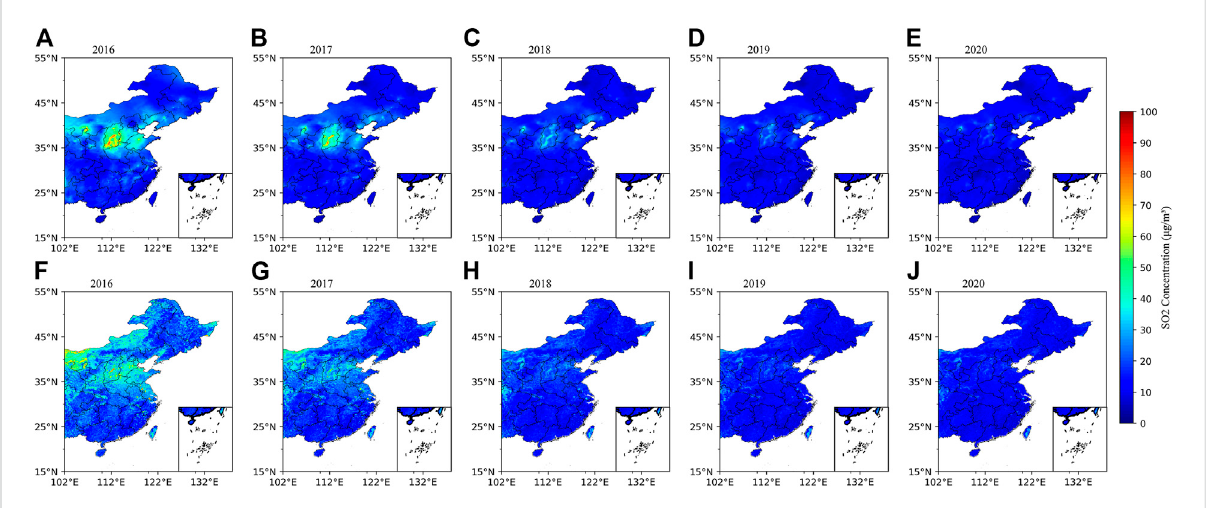
FIGURE 11 Comparison of annual average SO 2 concentrations in eastern China between our results and the ChinaHighSO 2 . (A – E) the results of ChinaHighSO 2 , and (F – J) the results of our